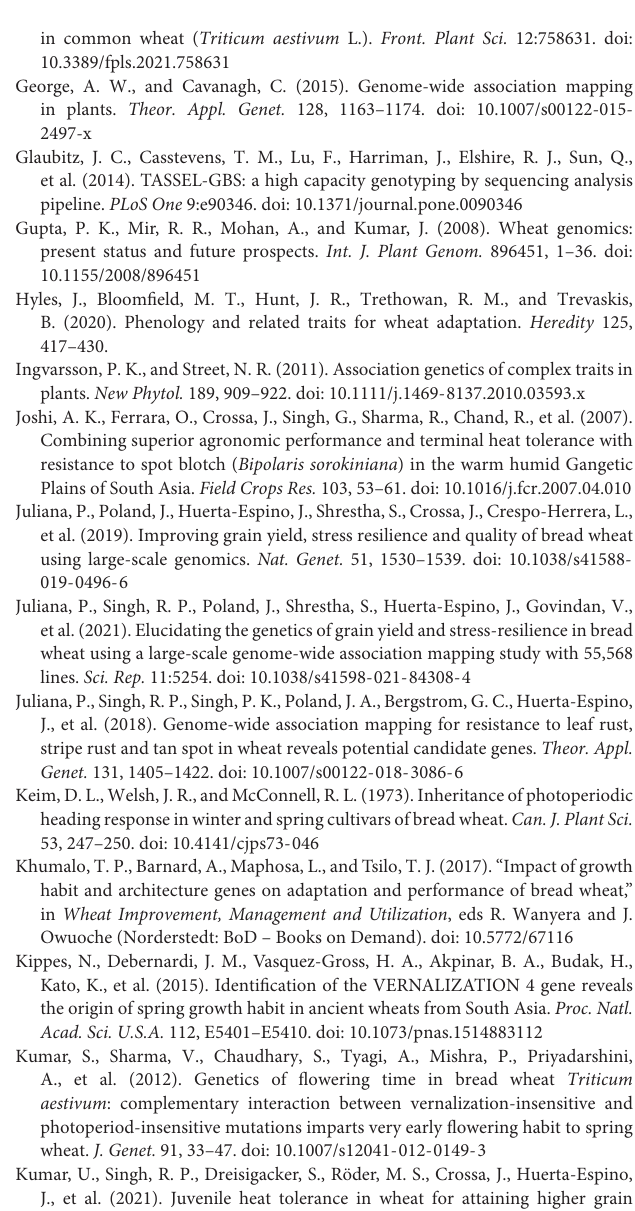
Supplementary File 1 | Biplot and dendrogram of the genetic correlation matrix for the traits studied in the wheat association panel grown in three different environments in India from 2014–2021. Supplementary File 2 | Individual marker effect, position on each chromosome, and p -value with marker effect. Supplementary File 3 | Single-nucleotide polymorphism markers significantly associated with phenological traits (DH and DM). Supplementary File 4 | Consistent markers significantly associated with agro-morphological